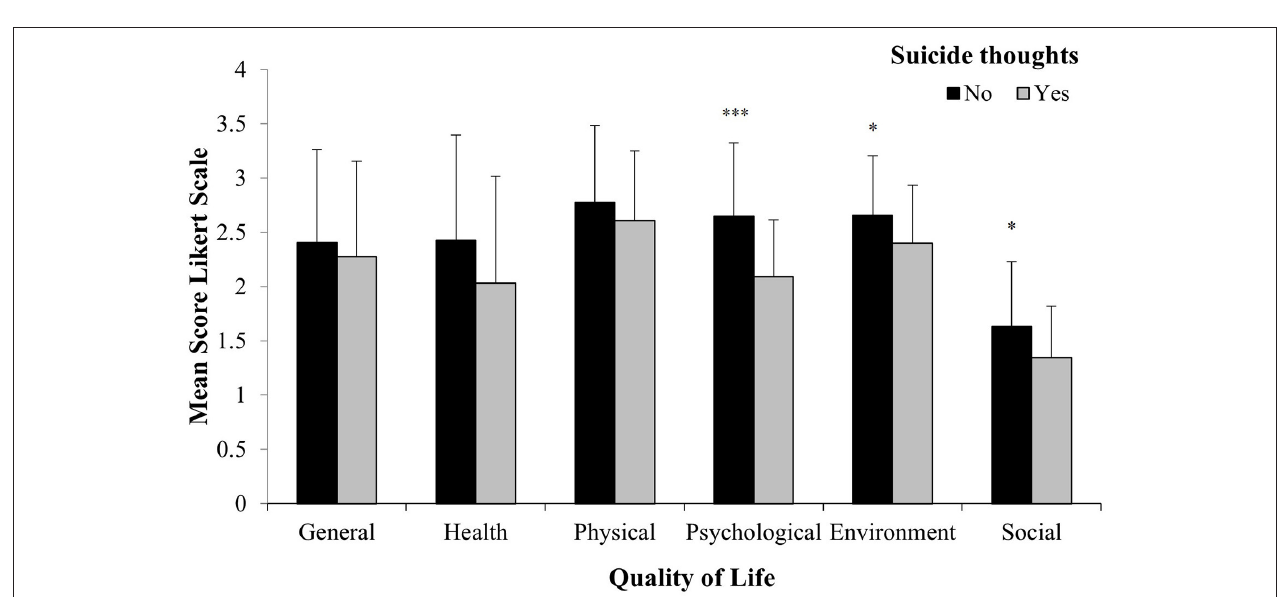
FIGURE 3 | Mean ( ± SD) of quality of life level in IPV exposed women with ( N = 29) and without ( N = 42) suicide thoughts. *** P < 0.001, * P < 0.05 vs. suicide thoughts.